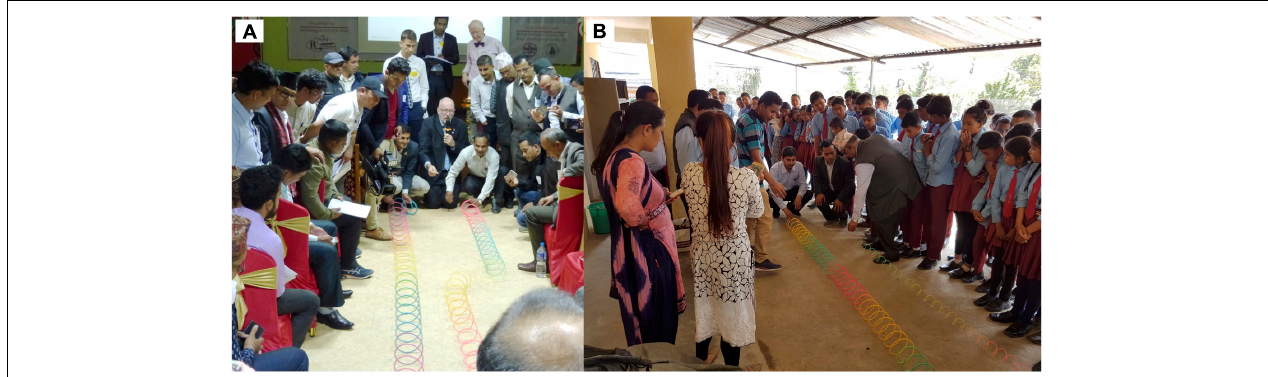
FIGURE 5 | Educational demonstration examples. (A) Nature of the S-wave propagation using a slinky, explained by Dr. Paul Denton (with microphone) and performed by a voluntary participant during the First International Workshop on Education Seismology in April 2019 in Pokhara, Nepal. More than 80 school teachers participated in the workshop. (Photo Credit: Peter Loader). (B) Shiba Subedi (in T-shirt) demonstrates a P-wave using a slinky and discusses its nature with students in Balmandir Secondary School, Gorkha district. (Photo Credit: School). All people or their legal representatives on the photos have agreed to be taken on picture and to be presented in frame of this research